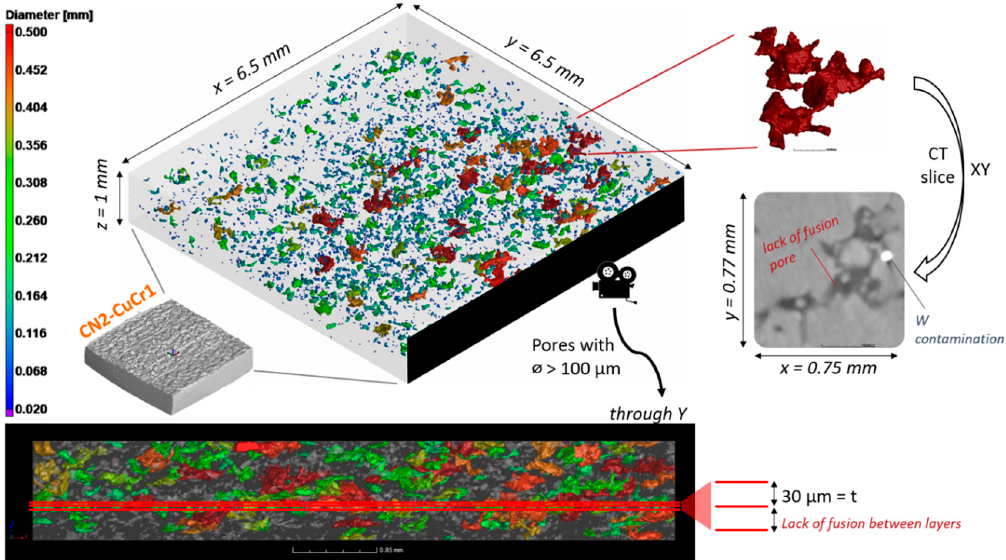
Figure 10. Overview of the porosity distribution for the CN2-CuCr1 sample, comprising a color-coded 3D view of the porosities, a zoomed insert of one exemplary lack-of-fusion pore, and a view through the Y direction of the sample to highlight the distribution of the defects in the building direction Z.